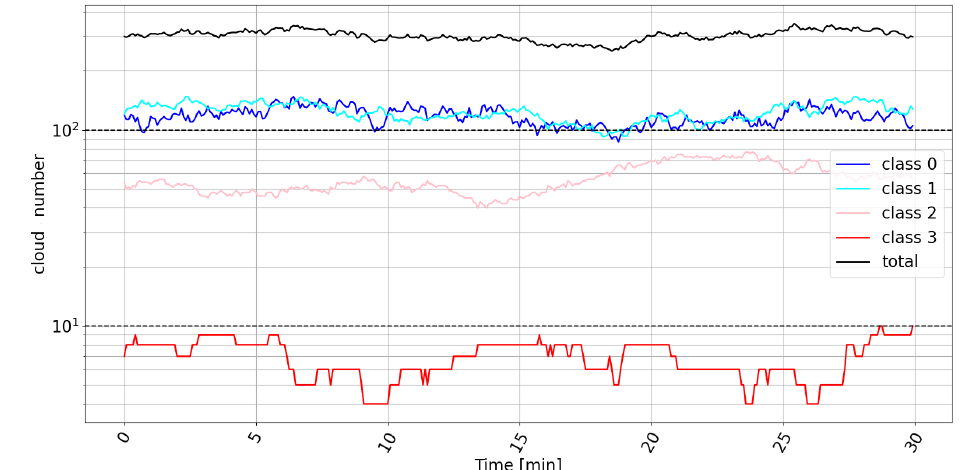
Figure 4. Temporal evolution of the number of clouds at each model output classified by their different volumes from Table